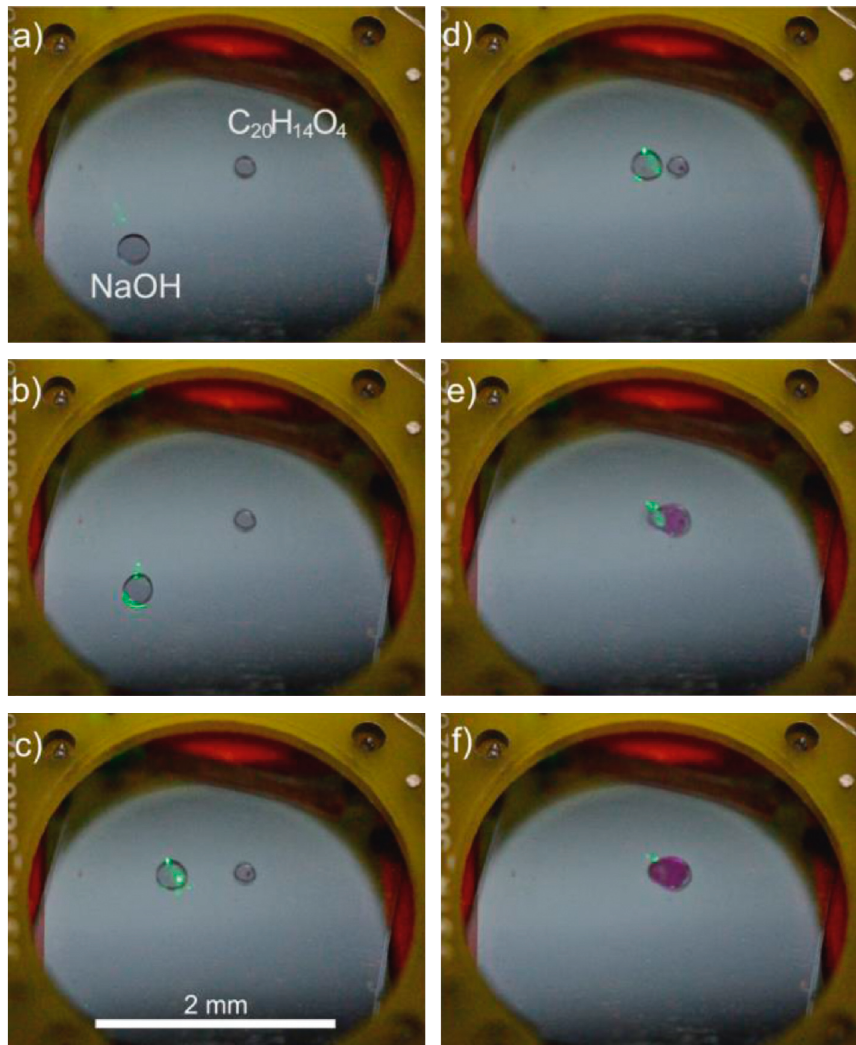
Figure 5: Frames from a video showing the droplet movement and mixing of sodium hydroxide (NaOH) and phenolphthalein (C with the help of laser beam-based OEW. The beam is perpendicularly incident from below the chip. A spot of scattered light can be observed, since the photoconductive a-Si :H layer is thin enough (780 nm) to transmit some of the OEW control light at 520nm wavelength. The NaOH droplet is moved to the C 20 H 14 O 4 droplet and both merged. The new droplet changes the color from colorless to purple. Transmission spectra of the single droplets and the resulting droplet are